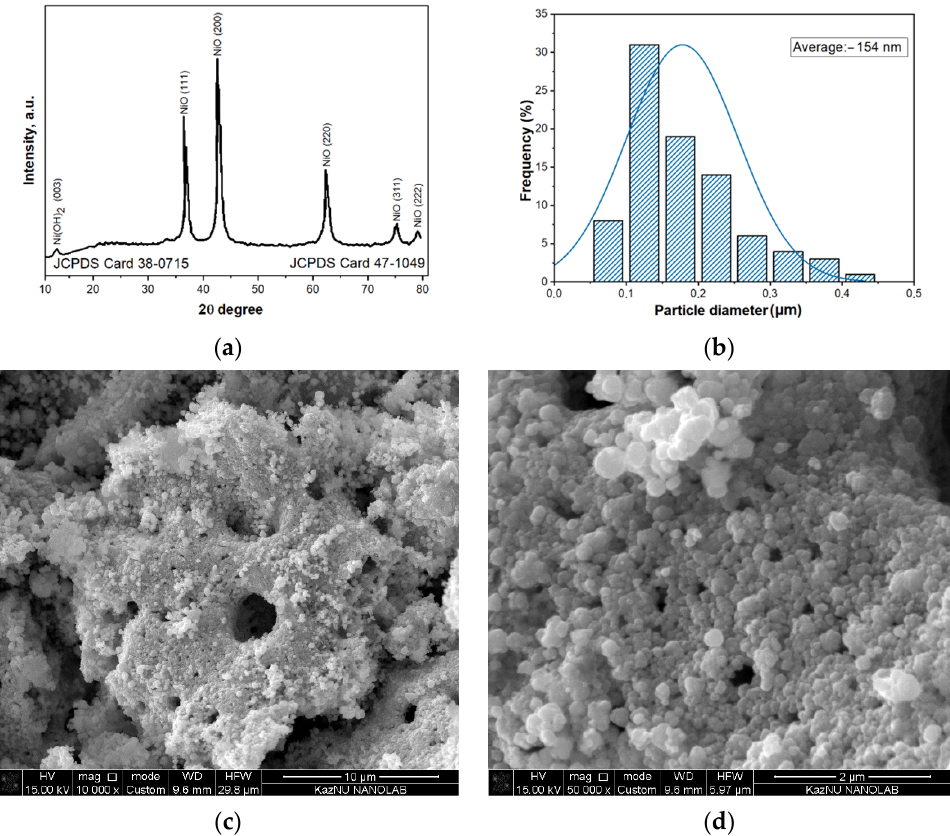
Figure 1. Results of characterization nickel oxide nanoparticles: ( a ) XRD, ( b ) distribution of the diameter of NiO nanoparticles, ( c , d ) SEM in SE mode. XRD diffraction pattern includes 5 peaks. The diffraction peaks at 37.27, 43.27, 62.84, 75.42 and 79.36 ◦ of 2 θ correspond cubic NiO crystallites with various diffracting planes (111), (200), (220), (311) and (222). All these diffraction peaks accordance with the standard spectrum (JCPDS Card 47-1049). The small peak at 12 ◦ most likely corresponds to